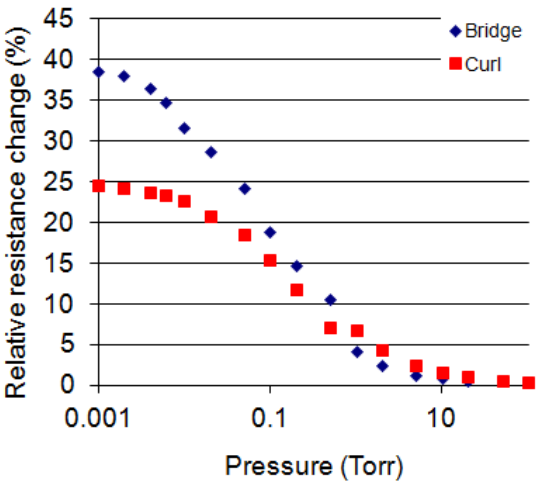
Figure 7. Relative resistance change (%) versus pressure of a curl device (bottom) and of a bridge device (top). The power applied to the heating elements at 760 Torr was 2 mW. The devices were measured in constant voltage